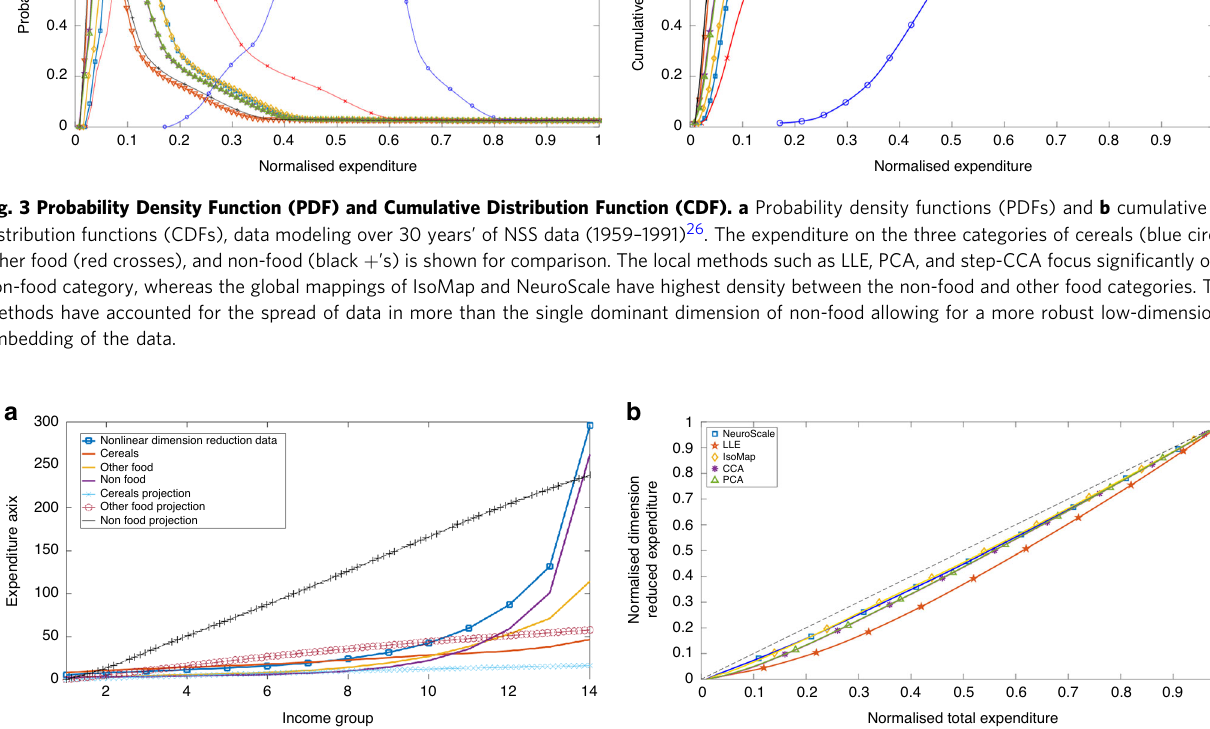
P 3 w ¼ 1, C i ( i = 1, 2, 3) being the three eigenvectors and w i are the normalized i i ¼ 1